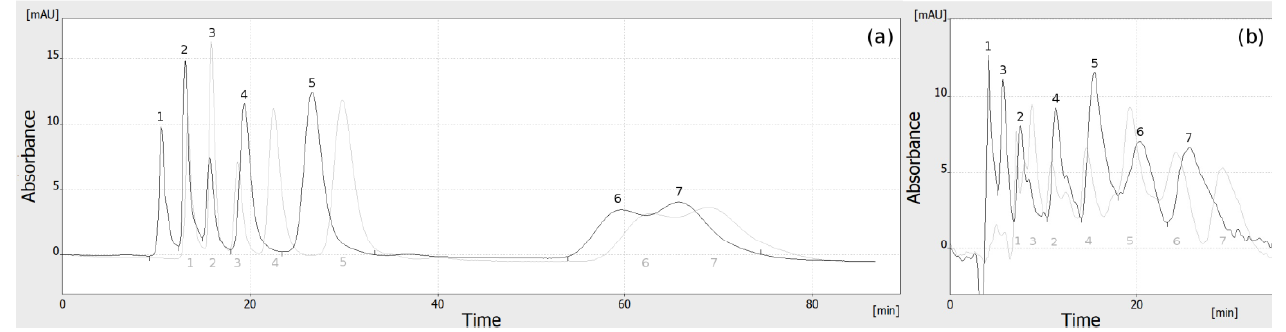
Figure 3. Comparison of multi-channel OPLC ( a ) and HPLEC ( b ) of the dye mixture: 1 µL of the mixture was applied to the five separation channels, with 3 min delay between sample application in each subsequent channel. Signals from only two channels are shown — no. III (black) and no. IV (grey). Separation system used: HPTLC RP-18 W chromatographic plates; water/methanol (3/2 v/v ) with addition of 80 mM ammonium formate pH 3.0 as the mobile phase; total mobile phase flow 0.25 mL/min ( a ) 0.34 mL/min ( b ); voltage 0 kV ( a ), 4.2 kV ( b ); temperature 25 °C, cushion pressure 100 bar; and mobile phase backpressure 96 bar ( a ), 93 bar ( b ). Dye mixture: 1 — indigotine 0.0125% w/v ; 2 — sunset yellow 0.025% w/v ; 3 — o-nitroaniline 0.0125% w/v ; 4 — allura red 0.0375% w/v